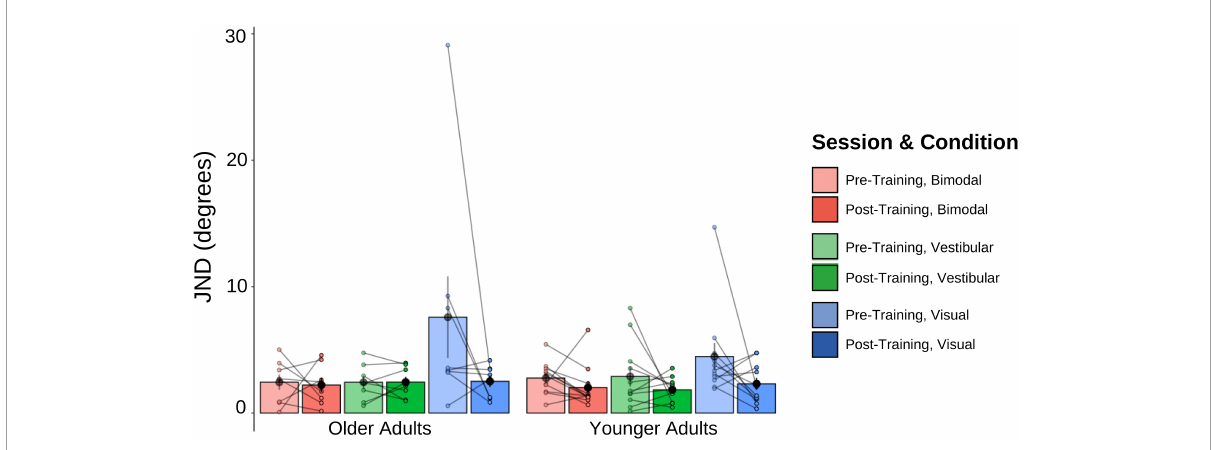
FIGURE5 Mean and individual JND values plotted for each Age Group and sensory condition, pre-training (lighter shades) and post-training (darker shades). Individual data points are also plotted, with lines connecting each participant’s pre-training JND to their post-training JND for each of the three sensory conditions (visual-only, vestibular-only, bimodal). Black dots represent means, plotted with standard error bars.